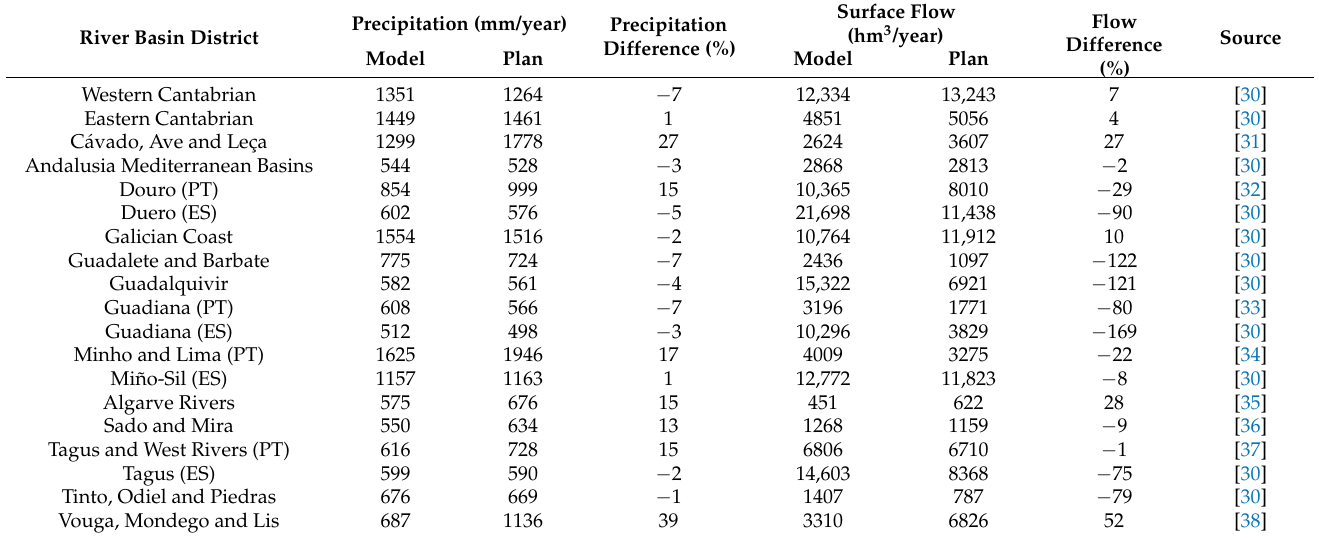
Table 4. Comparison of annual precipitation and surface flow between model and official values of river basin management